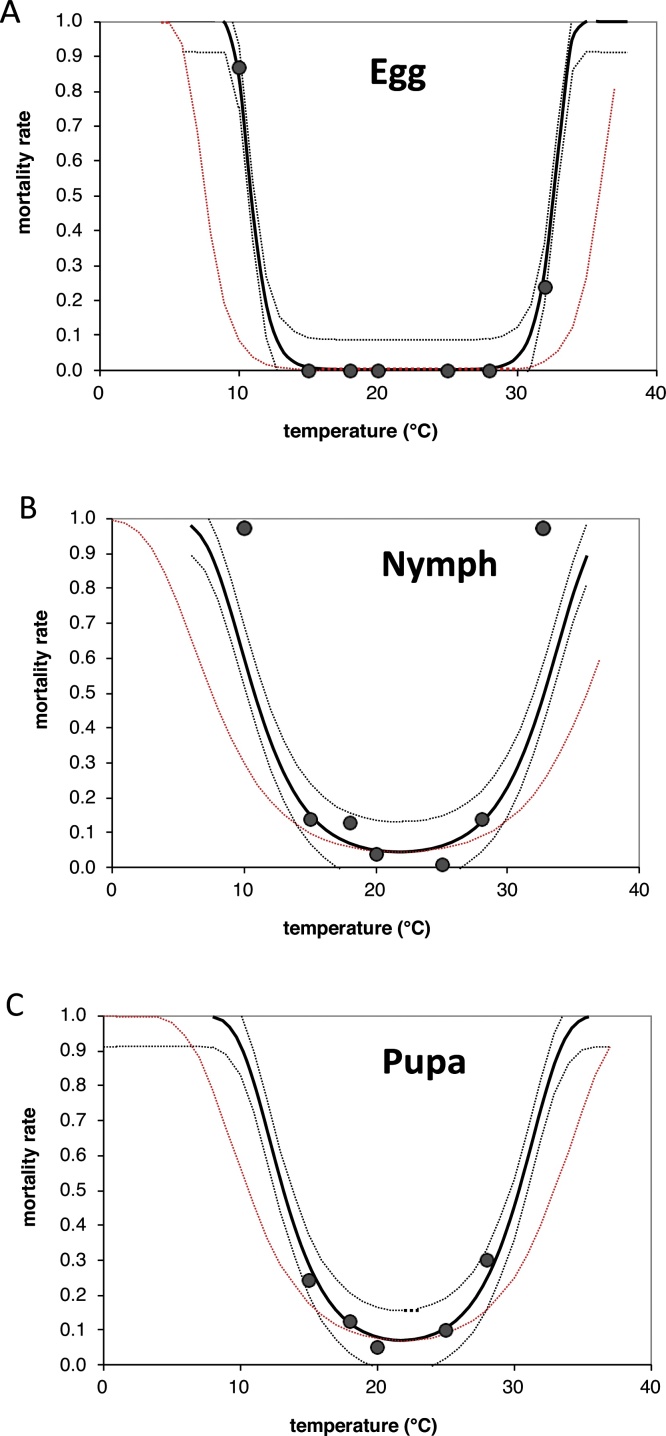
Temperature-dependent mortality ratios of T. vaporariorum immature life stages (A: eggs, B: nymph, C: puparium); dots: observed data; lines: nonlinear models fitted; dashed lines: upper and lower 95 % confidence limits of the model. Dashed red lines represent the model used for fluctuating temperature (adjusted model).